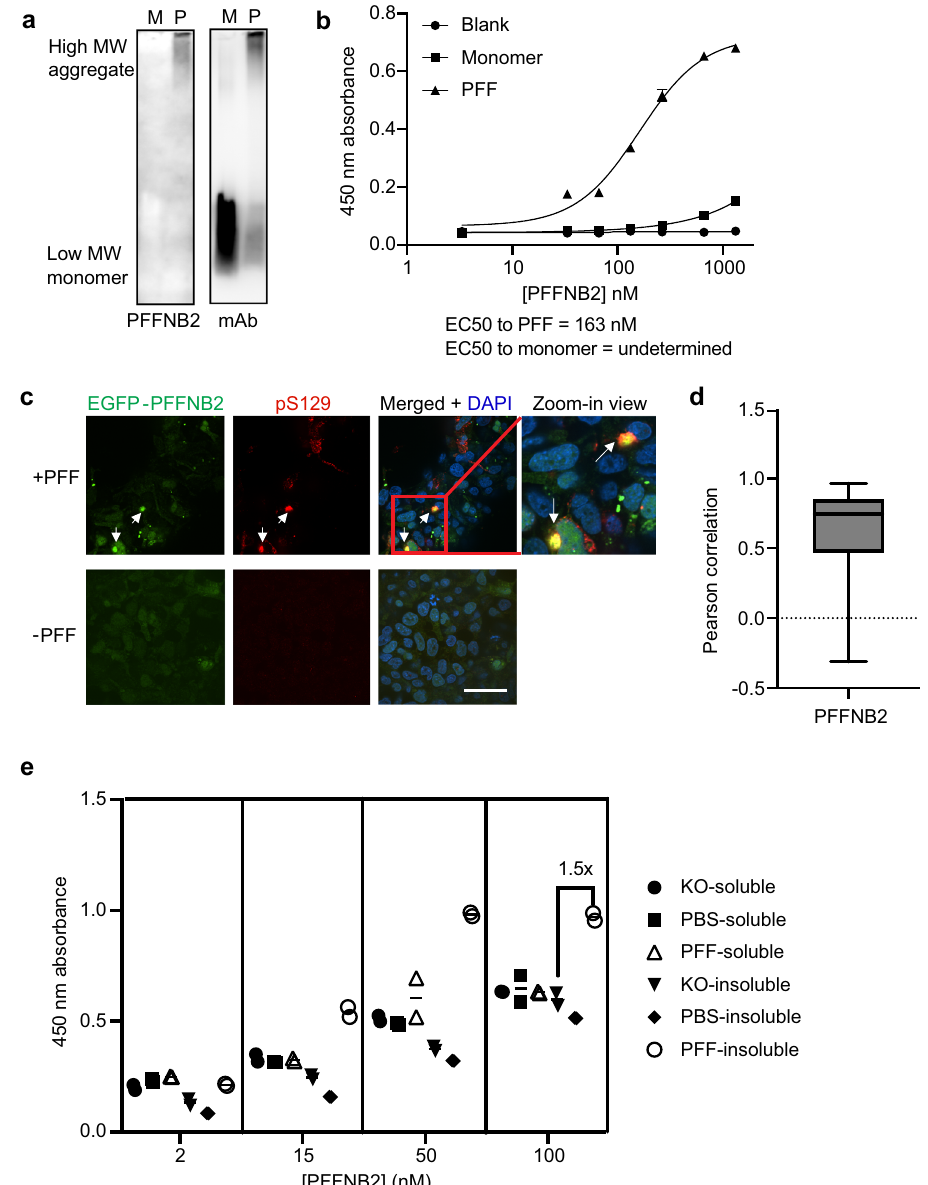
Fig. 2 In vitro characterization of PFFNB2 binding to α -syn PFF and aggregates. a Native-PAGE immunoblot of human α -syn monomers and PFF with PFFNB2 and anti- α -syn monoclonal antibody (mAb). PFFNB2 binds selectively to the high molecular weight (MW) α -syn but not to the low MW α -syn. Anti- α -syn mAb binds to both the high and low MW α -syn forms. M, α -syn monomers. P, α -syn PFF. mAb, anti- α -syn monoclonal antibody. The experiment was replicated three times with similar results. b ELISA result of PFFNB2 binding to α -syn PFF, monomers, and control (blank). Wells were coated with 3 ng/ μ l of α -syn PFF or monomers, and then titrated with 3.3, 33.3, 66.7, 133.3, 266.7, 666.7, and, 1333.3 nM of PFFNB2. Three data points were collected for each concentration and shown as mean ± SEM. The experiment was replicated once with similar result. c AAV-transduced EGFP-PFFNB2 (green) signal co-localized with the immunostaining of anti-pS129 in HEK293T cells stably expressing α -syn(A53T) induced by α -syn PFF. Green, EGFP- PFFNB2 signal. Red, anti-pS129 immuno fl uorescence signal. White arrows indicated the co-localization between EGFP-PFFNB2 and pS129 α -syn. Scale bar, 40 μ m. d Quanti fi cation of co-localization between pS129 α -syn signal to PFFNB2 using Pearson correlation. Data were analyzed from 103 puncta. The box ranges from the fi rst to the third quartile of the distribution with median indicated as line across the box. The whiskers are the minimum and maxima of the data. e ELISA analysis of PFFNB2 binding to mouse brain lysate. KO, Snca knock-out mouse; PBS, transgenic mouse expressing human α -syn with striatal- PBS injection; PFF, transgenic mouse expressing human α -syn with striatal-PFF injection. Wells were coated with 3 ng/ μ l of each brain lysate, and then detected with 2, 15, 50, 100 nM of PFFNB2. Two data points were collected for each concentration. The experiment was replicated once with similar result. Source data are provided as a Source Data fi